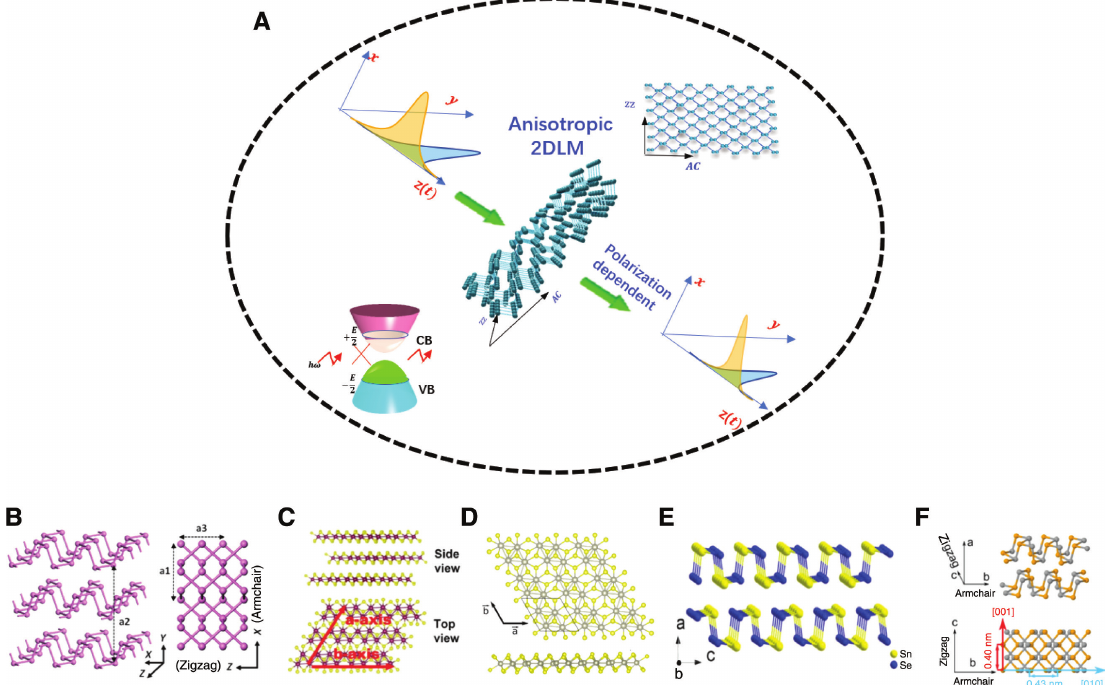
Figure 1: Anisotropic 2DLMs for ultrafast application. (A) Schematic diagram of polarization-dependent pulse shaping by anisotropic 2DLMs. The crystal structure of typical anisotropic 2DLMs. (B) Orthorhombic black phosphorus (BP). Reproduced with permission from Ling et al. [93]. (C) Triclinic ReS from Meng et al. [94]. (D) Triclinic ReSe . Reproduced with permission from Echeverry and Gerber [95]. (E) Orthorhombic SnSe. Reproduced 2 with permission from Ye et al. [40]. (F) Orthorhombic SnS. Reproduced with permission from Tian et al.